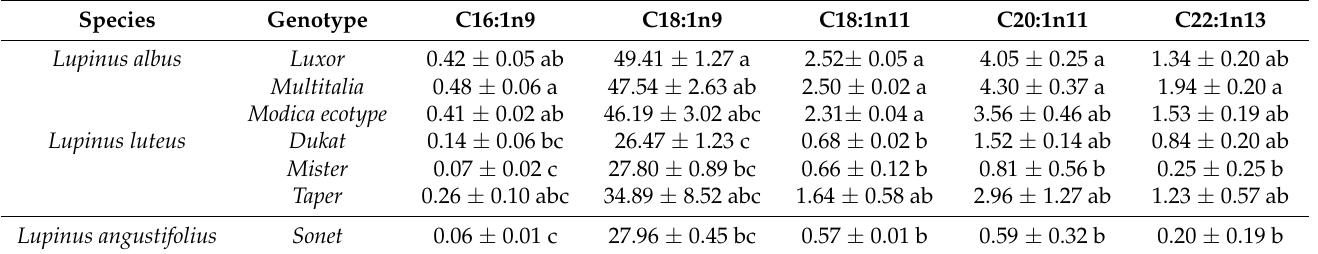
Table 5. Monounsaturated fatty acid profiles of seed oil extracted from different Lupinus spp. genotypes.